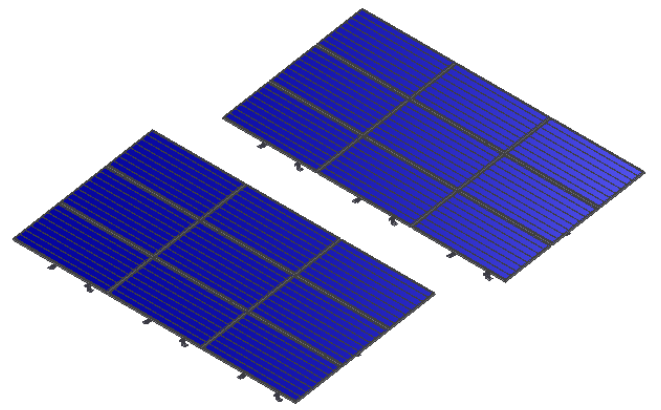
Figure 10. Case III — 3D representation ofthree-row landscape configuration. The total population size, in this case, was 4096. The genetic algorithm method was used to find the optimum configuration. Around 10% of the population (400 individuals) obtained for each iteration.